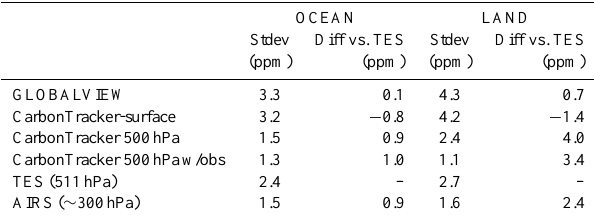
Table 6. Variability and mean differences of monthly average